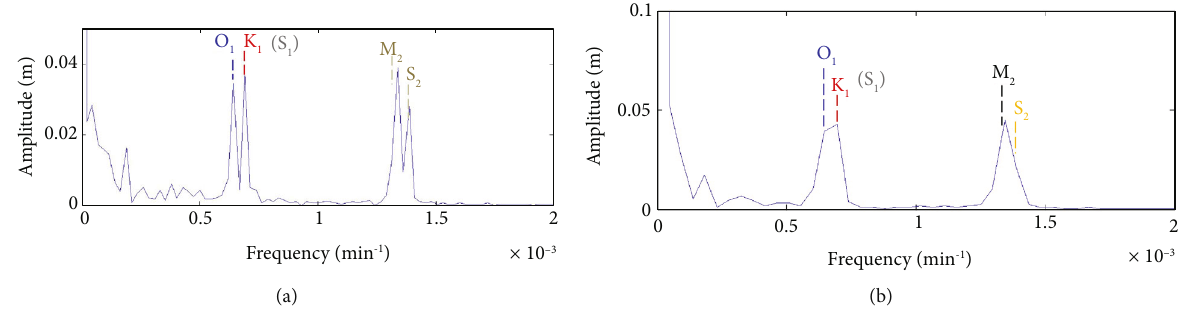
Figure 12: (a) Spectrum analysis of a time series of 27.95 days. (b) Spectrum analysis of a time series of 15 days (both with data before occurrence of the 2008 Wenchuan earthquake).